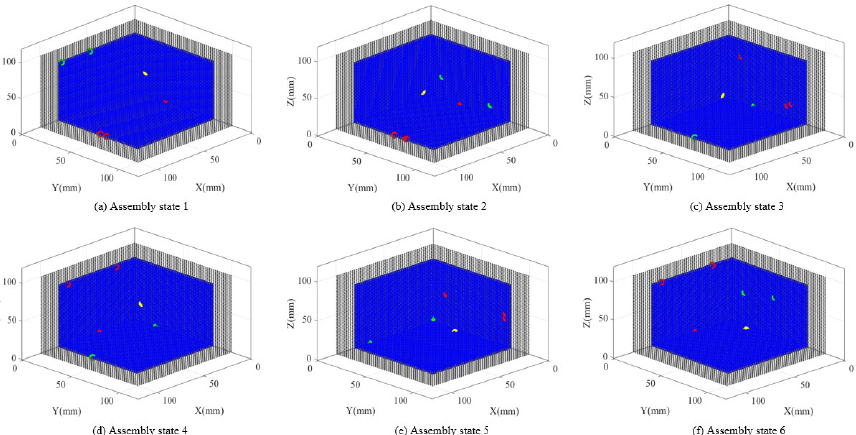
Figure 10. Variations of six contact points. The three contact points on the main mating plane are red, the two contacts point on the first auxiliary mating plane are green, and the contact point on the second auxiliary mating plane is yellow.